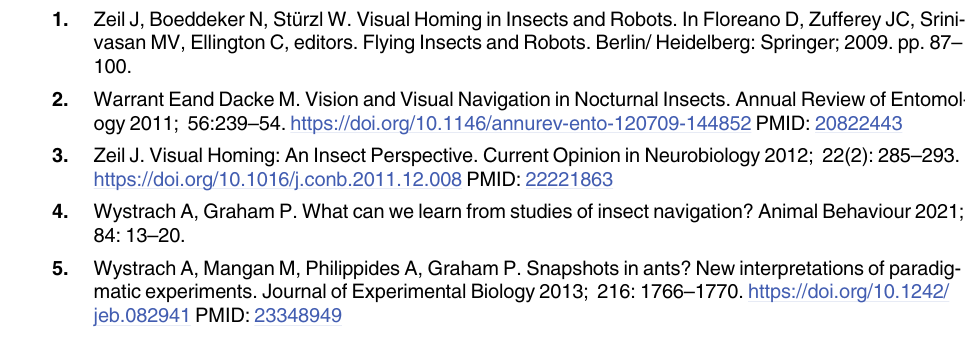
S2 Fig. Top: Example of the visual features at the site of a barrier experiment. Bottom: The scene a wasp is confronted with when the barrier is in place. Arrow points to the wasp’s burrow. (TIF) S1 Data. Excel spreadsheet containing data used for Fig 6H: x/y position of means of search distributions relative to the true nest location for 12 wasps for each of the conditions A-G. Same for the spread of search distributions.